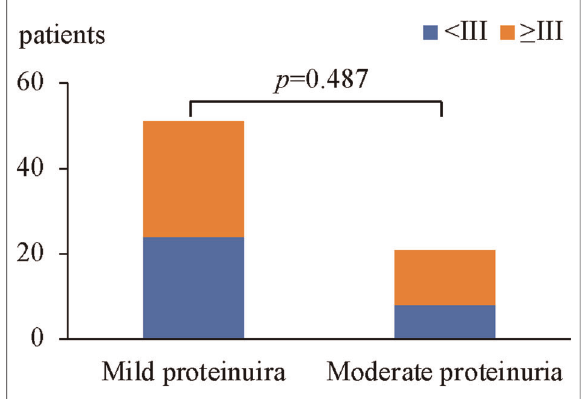
FIGURE 2 Comparison of renal pathological grades ≥ III between the wild proteinuria and moderate proteinuria group.